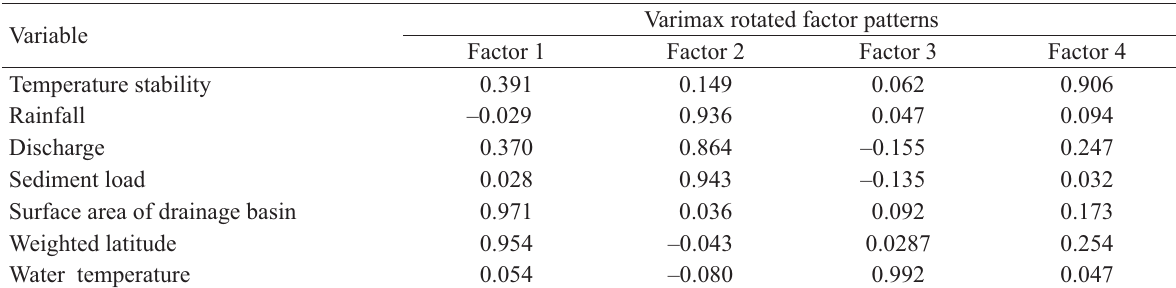
Varimax rotated factor loading of each variable